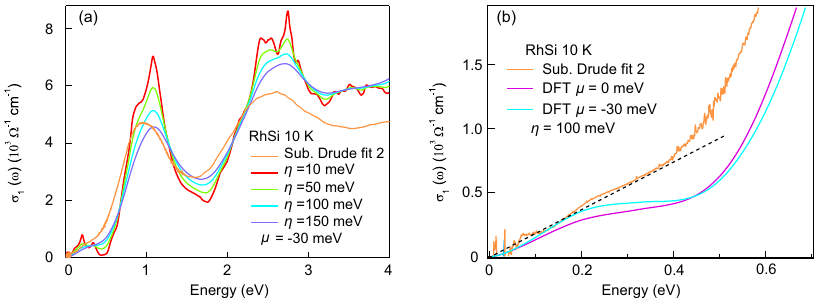
Fig. 5 Calculated optical conductivity by DFT. a Full frequency-range optical conductivity comparing different broadening factors η , with fi xed μ = − 30 meV. The η = 100 meV curve shows a relatively good agreement up to 4 eV. b Low-energy optical conductivity data compared to DFT results calculated at different chemical potentials μ and a disorder broadening η = 100 meV. The black dashed line is a guide to the eye, highlighting the small deviations from linearity and a small shoulder in the data around 200